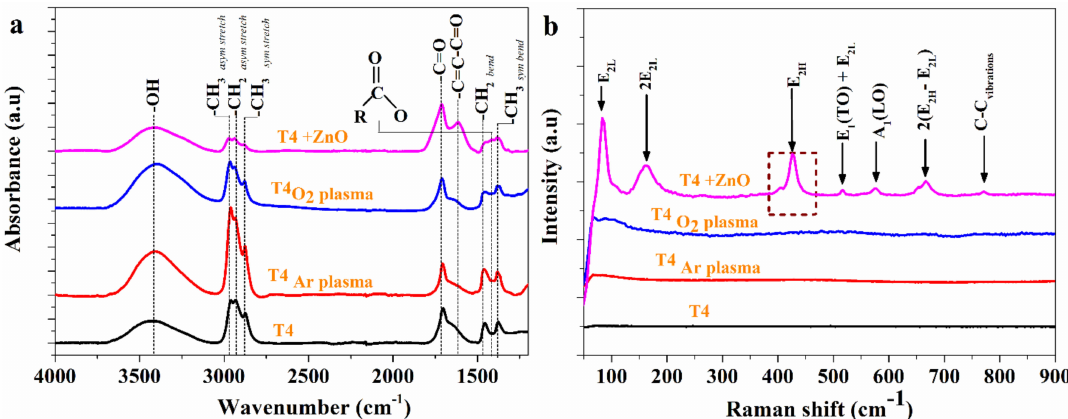
Figure 3. ( a ) ATR-FTIR spectra of ZnO nanoparticle functionalized and wettability modified T4 surfaces; ( b ) Raman spectra of modified T4